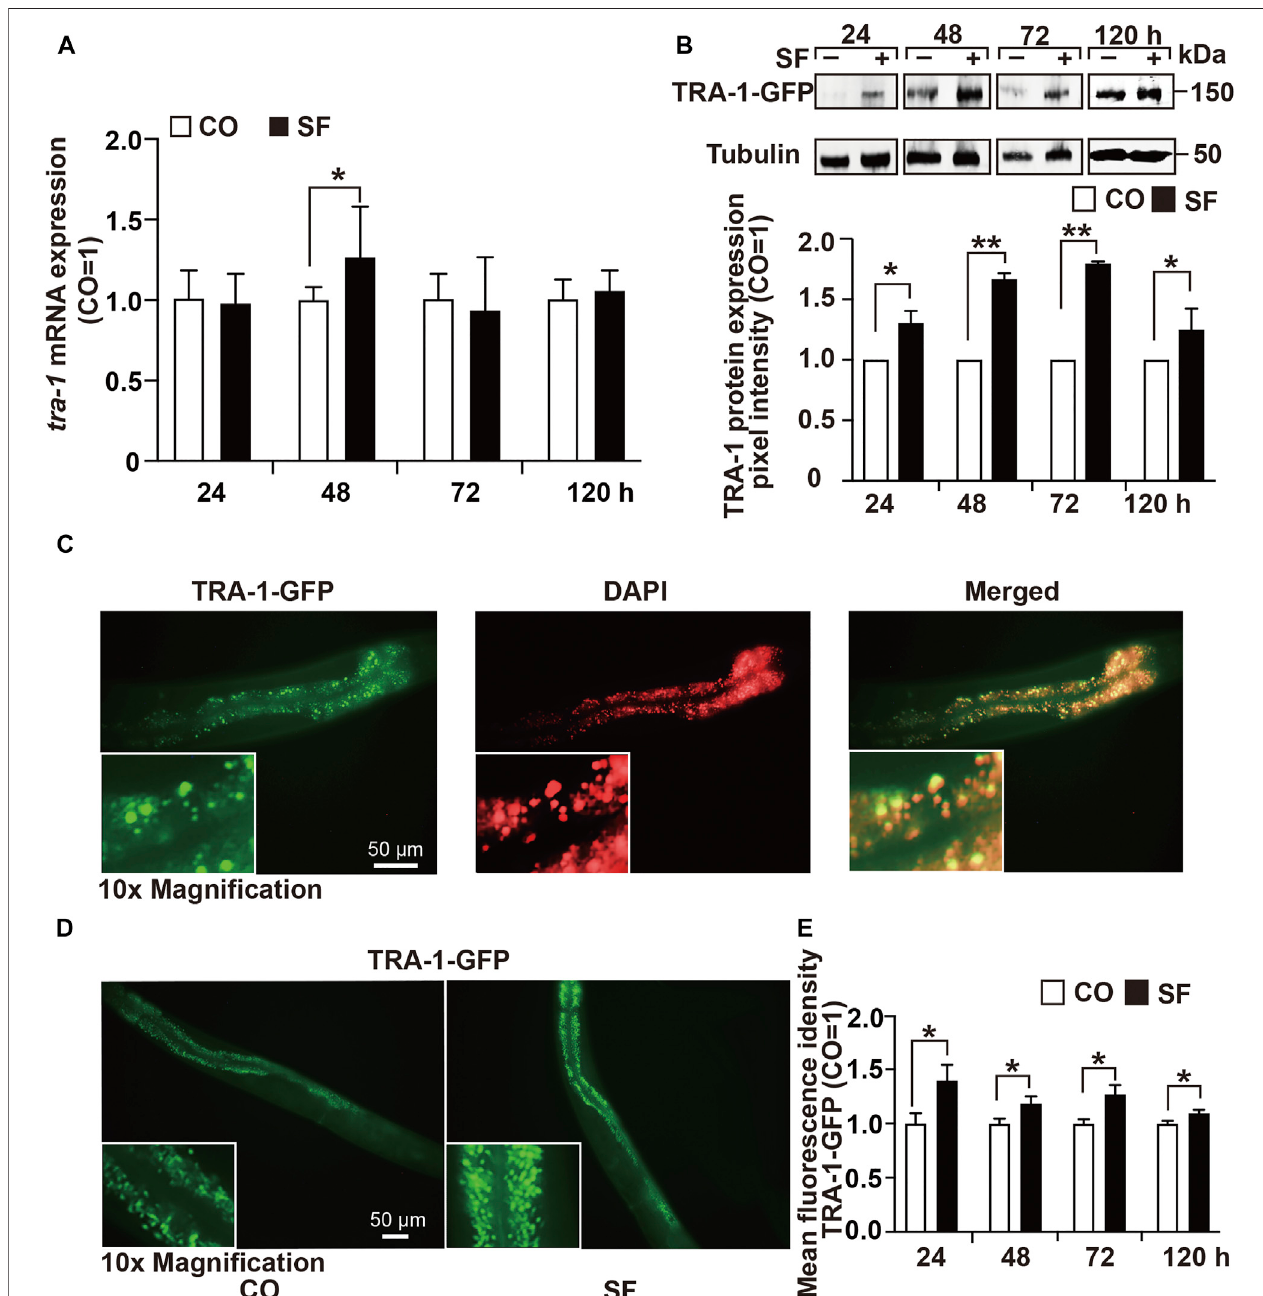
FIGURE2| TRA-1expressionisupregulatedbysulforaphane. (A) Synchronized N2wild-type C.elegans L4larvae( n (cid:1) 200/group)obtained100 µMsulforaphane (SF) in their growth plates or were left untreated in the control (CO). Next, 24, 48, 72, and 120 h later, the total RNA was extracted, and the expression of tra-1 was detected by RT – qPCR. The expression of tra-1 is given as the fold change and is normalized to the control group, whose expression was set to 1. (B) Synchronized RA7 C. elegans worms expressing a tra-1 -GFP fusion gene were treated with sulforaphane (SF) or were left untreated in the control (CO). Proteins were extracted from 200 worms per group at 24, 48, 72, or 120 h after sulforaphane feeding, and the expression of TRA-1 was detected by Western blot analysis using a GFP-speci fi c antibody. Detection of tubulin expression served as a control for equal loading conditions. The protein sizes in kilodaltons (kDa) are provided (upper part). ImageJ was used to evaluate the pixel intensity of each band, and the expression was normalized to Tubulin. Next, the values in the sulforaphane group were related to those in the control group, which were set to 1. (C) The RA7 C. elegans strain was used to examine the expression of TRA-1-GFP by detecting green GFP fl uorescence by fl uorescence microscopy. The cell nuclei were counterstained with DAPI. The images were taken at × 400 magni fi cation. Insert: × 10 magni fi cation. The scale bar indicates 50 µm. (D) RA7 C. elegans worms ( n (cid:1) 10/group) were fed 100 μ M sulforaphane (SF) or not (CO), and 24, 48, 72, or 120 h later, the green spots, re fl ecting nuclear translocation of the TRA-1-GFP fusion protein, were detected by fl uorescence microscopy. Images were taken at × 200 magni fi cation. The inserts show a × 10 magni fi cation. The scale bar indicates 50 µm. (E) The mean fl uorescence intensities were quanti fi ed using ImageJ, and the statistical analysis is represented in the diagram. The data are shown as means ± SEM, as evaluated by Student ’ s t-test using SSPS 25. * p < 0.05, ** p < 0.01.